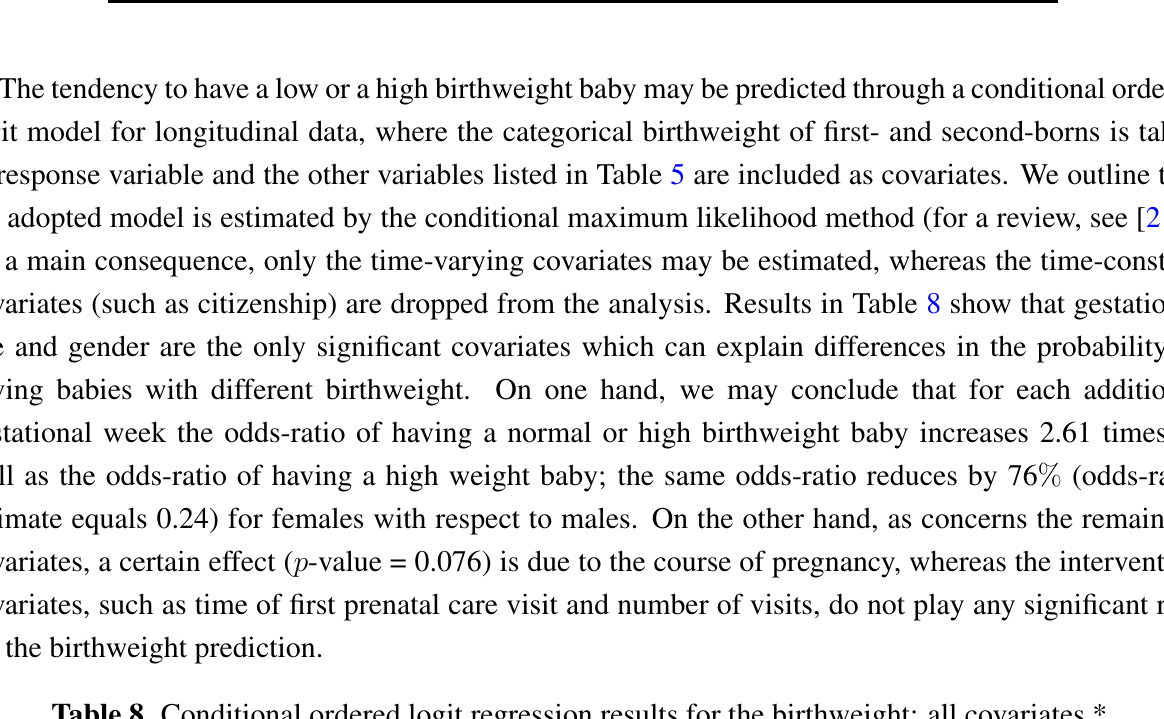
Table 8. Conditional ordered logit regression results for the birthweight: all covariates *.